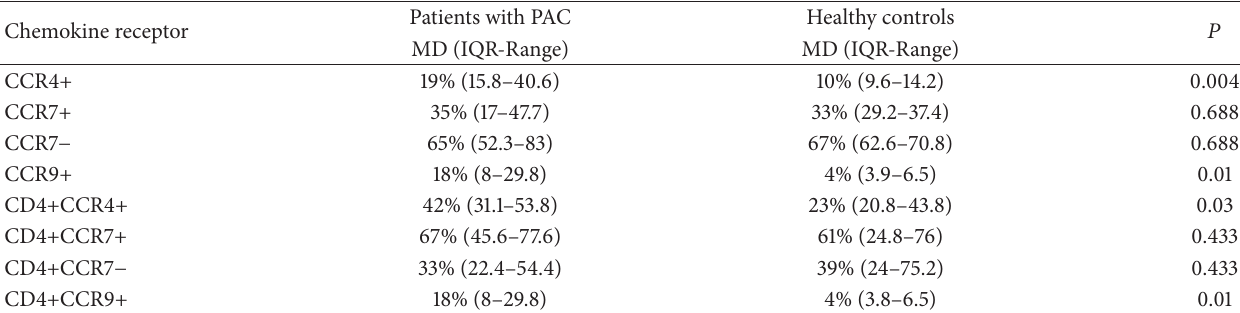
Table 1: Frequencies of chemokine receptors in patients with PAC and HC.